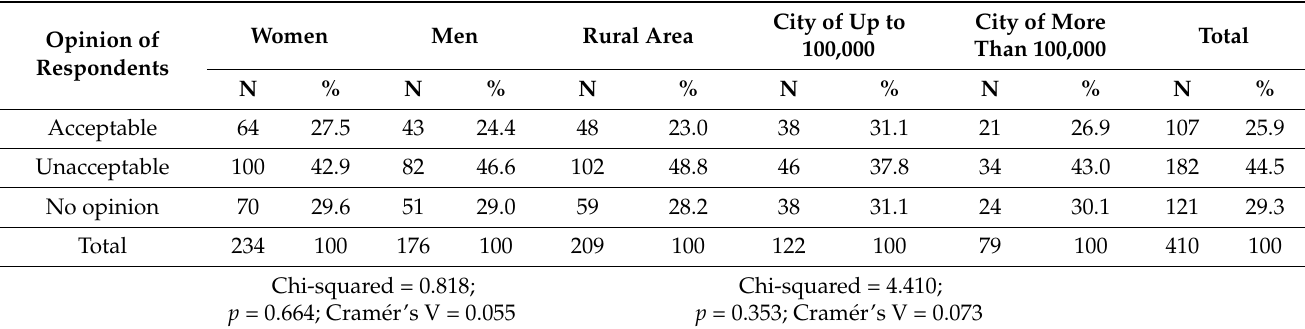
Table 5. Opinions on the acceptability of